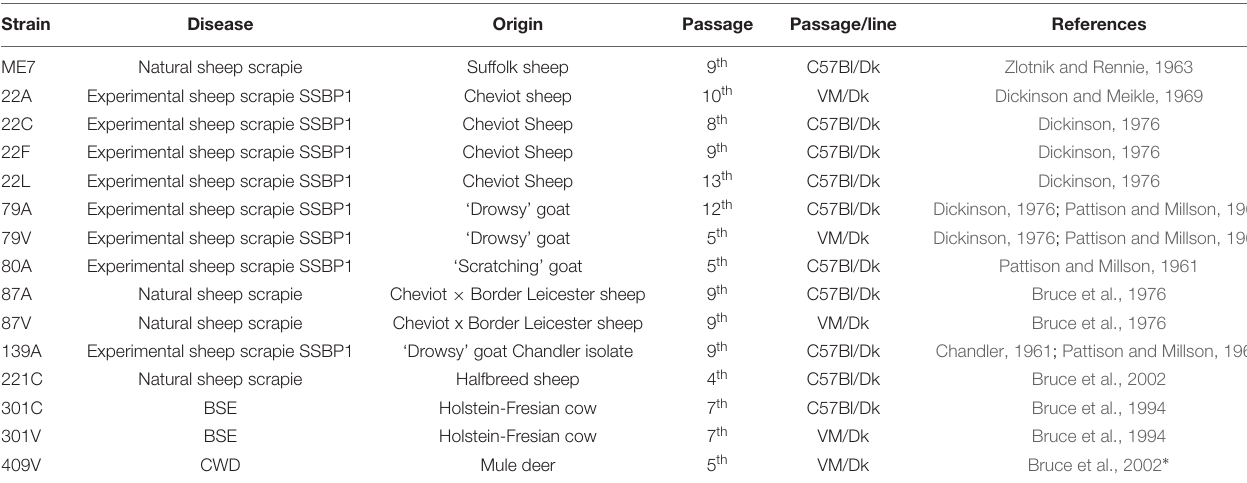
TABLE 1 | Prion agent strains analyzed in this